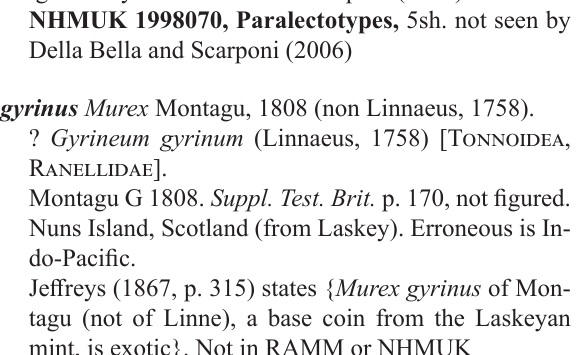
Bideford Bay. EXEMS Moll4257, Lectotype , 1sh. on blue card des- ignated by Della Bella and Scarponi